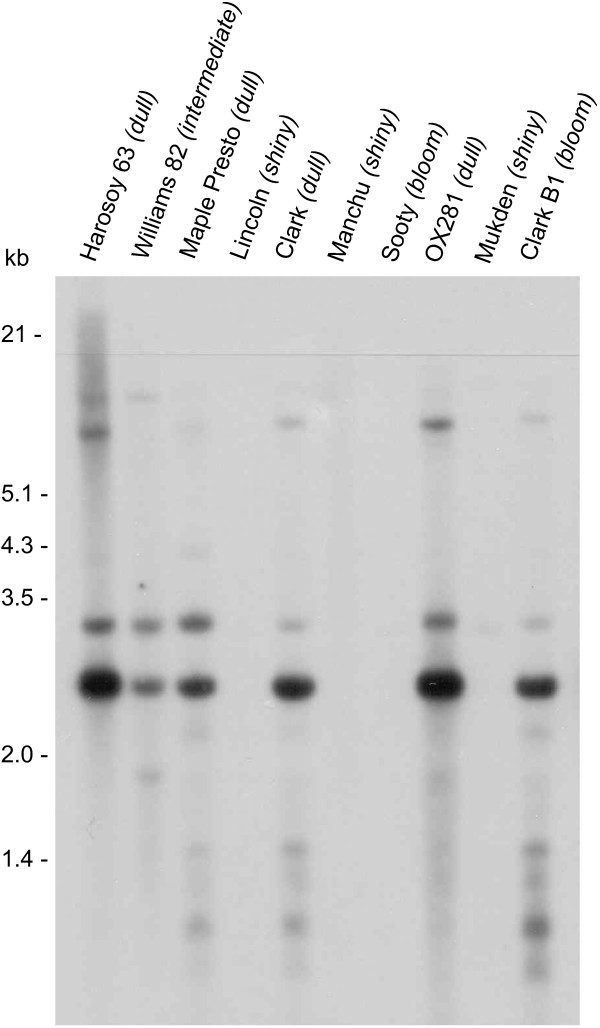
Analysis of Hps gene structure in various soybean cultivars and lines by DNA blot hybridization. Soybean (Glycine max) genomic DNA (30 μg each lane) was digested with Bgl II and separated by agarose gel electrophoresis. The DNA was transferred to Nylon blotting membrane and probed with 32P labelled Hps cDNA (GenBank accession number AF100159). The name of the soybean cultivar or line is shown above each lane along with the seed lustre phenotype in parenthesis. The migration of DNA size standards is shown on the left.